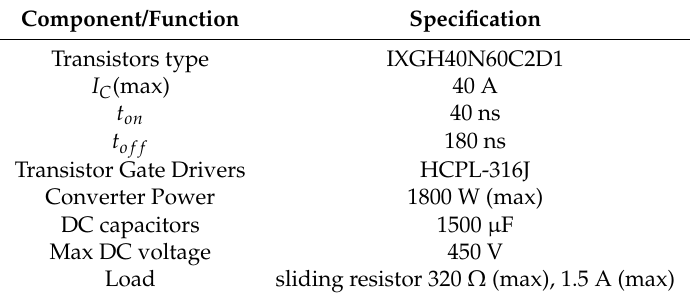
Table 1. The main parameters of buck-converter topology.